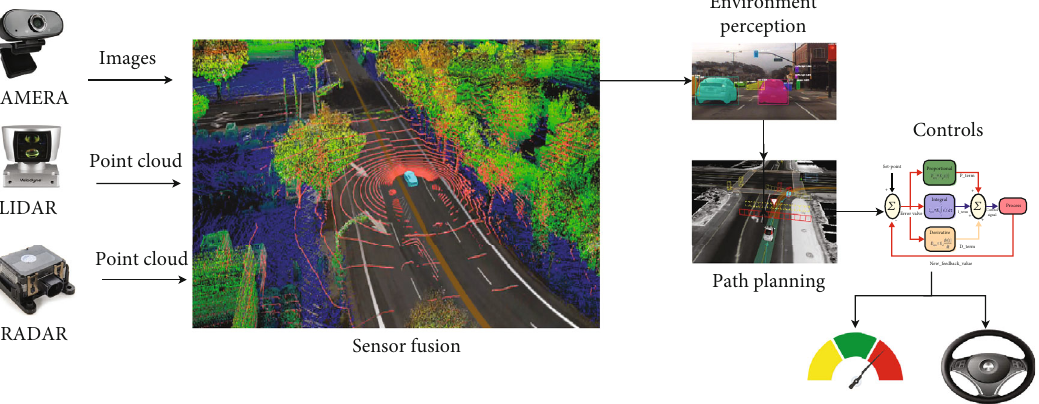
Figure 1: Traditional approach toward AV.